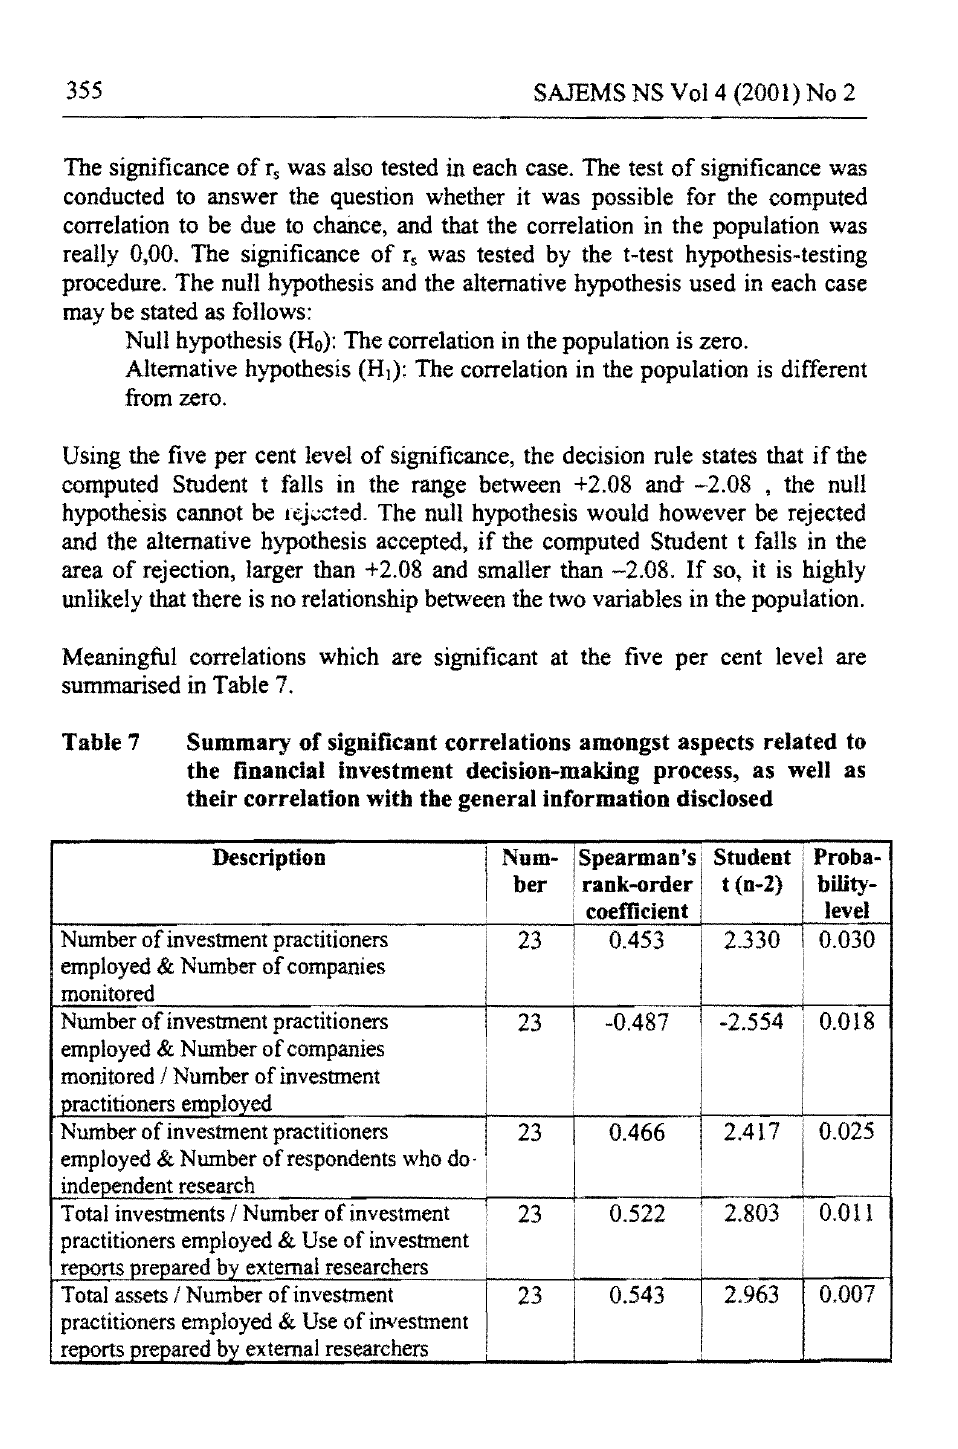
Summary of significant correlations amongst aspects related to the financial investment decision-making process, as well as their correlation with the general information